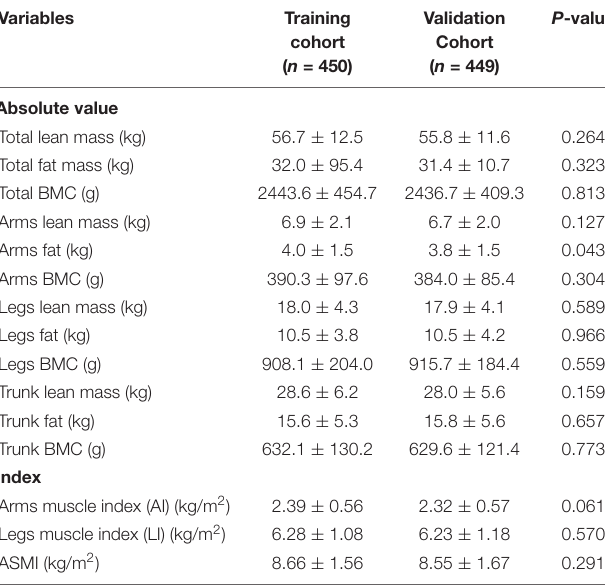
TABLE 2 | DXA characteristics of MAFLD patients in the 2017–2018